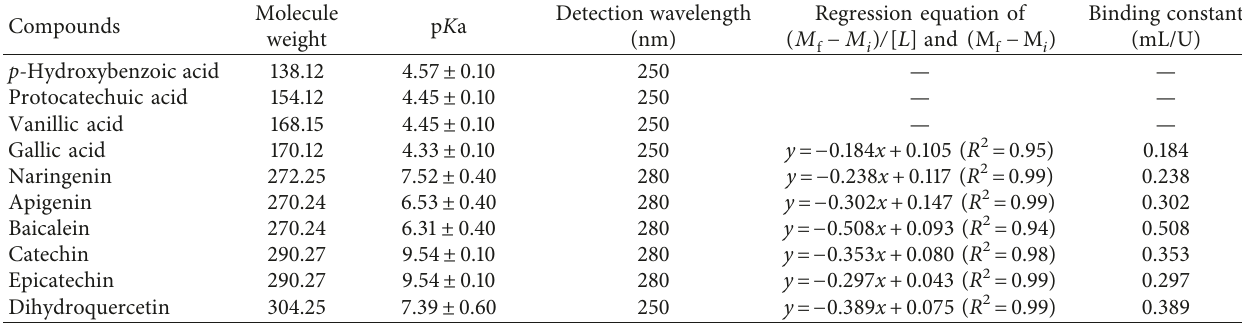
Table 1: Interactions of ten investigated compounds with thrombin evaluated by ACE.